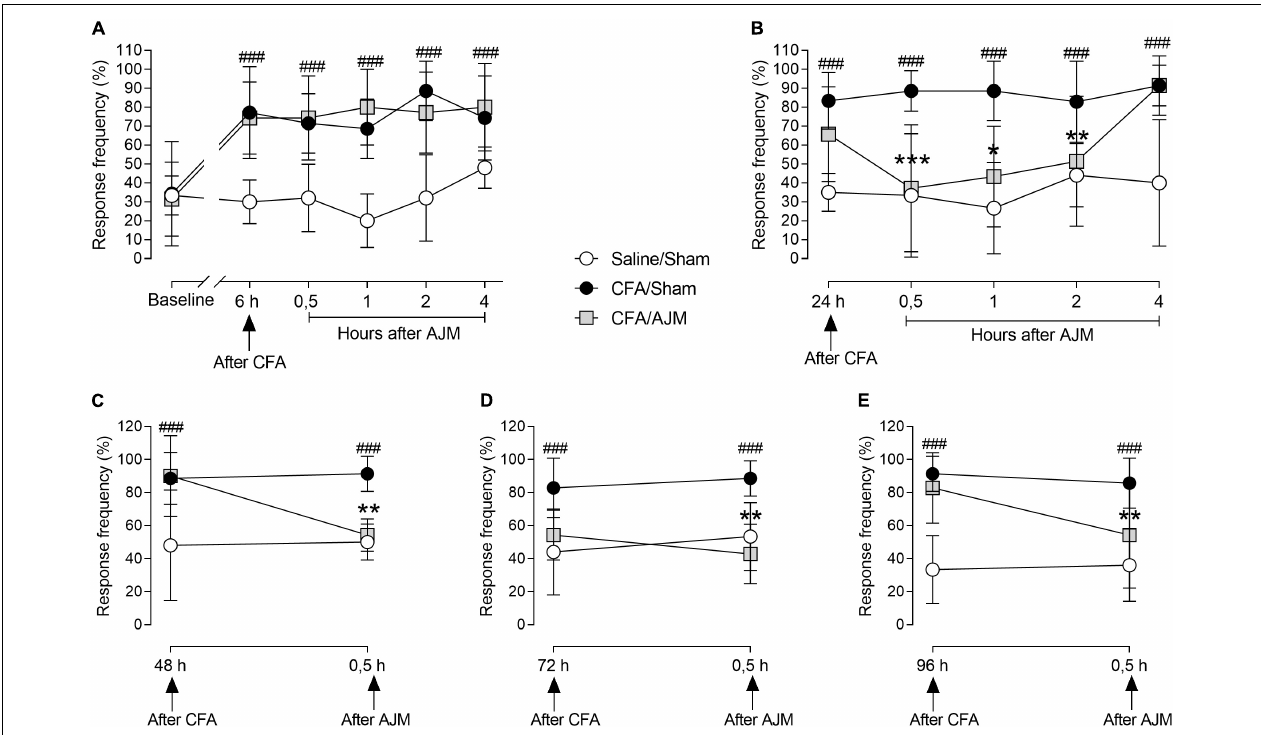
FIGURE 2 | Evaluation of mechanical hyperalgesia performed by the von Frey test, in male Swiss mice submitted to the intraplantar CFA model and treated with AJM. Baseline evaluations (prior to the procedure) are presented: the measures at 6 (A) and 24 h (B) after intraplantar CFA and the periods of 0.5, 1, 2, and 4 h (A,B) after AJM. Also, 48 (C) , 72 (D) , and 96 h (E) after injection of CFA and 0.5 h after AJM. The values represent the mean ± SD of seven animals per group, statistically compared by two-way ANOVA with repeated measures followed by Tukey’s post-hoc test. ### p < 0.001, when compared to the Saline/Sham group; * p < 0.05, ** p < 0.01, and *** p < 0.001, when compared to the CFA/Sham group. CFA, Complete Freund’s Adjuvant; AJM, Ankle Joint